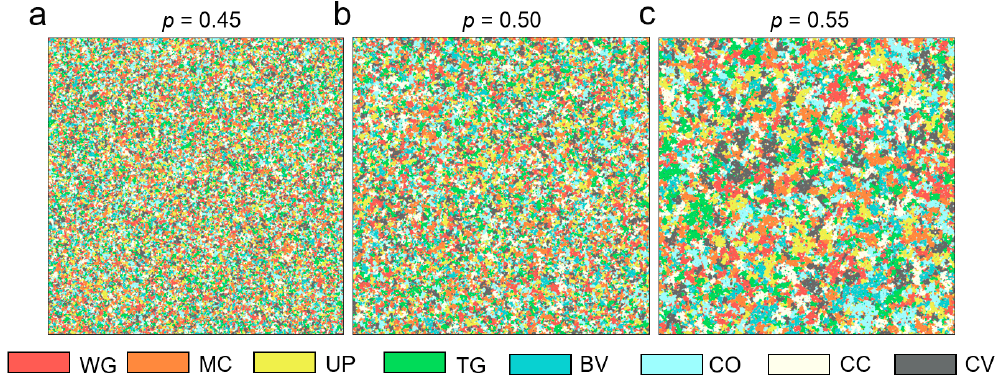
Figure 4. The simulation images from SIMMAP software with different degrees of landscape fragmentation represented by p values of 0.45, 0.50, and 0.55. Remote Sens. 2019 , 11 , x FOR PEER REVIEW